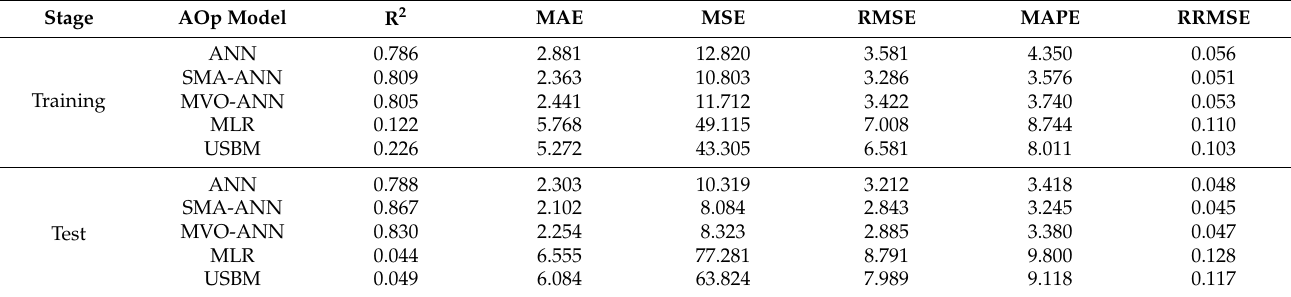
Table 3. AOp prediction model performance appraisal